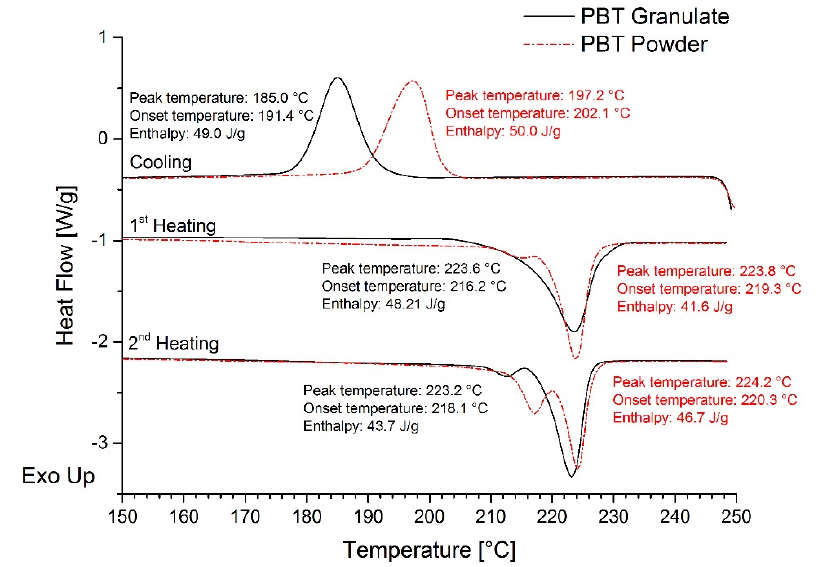
Figure 8. Differential scanning calorimetry (DSC) thermograms of PBT granulate (starting material) and produced PBT